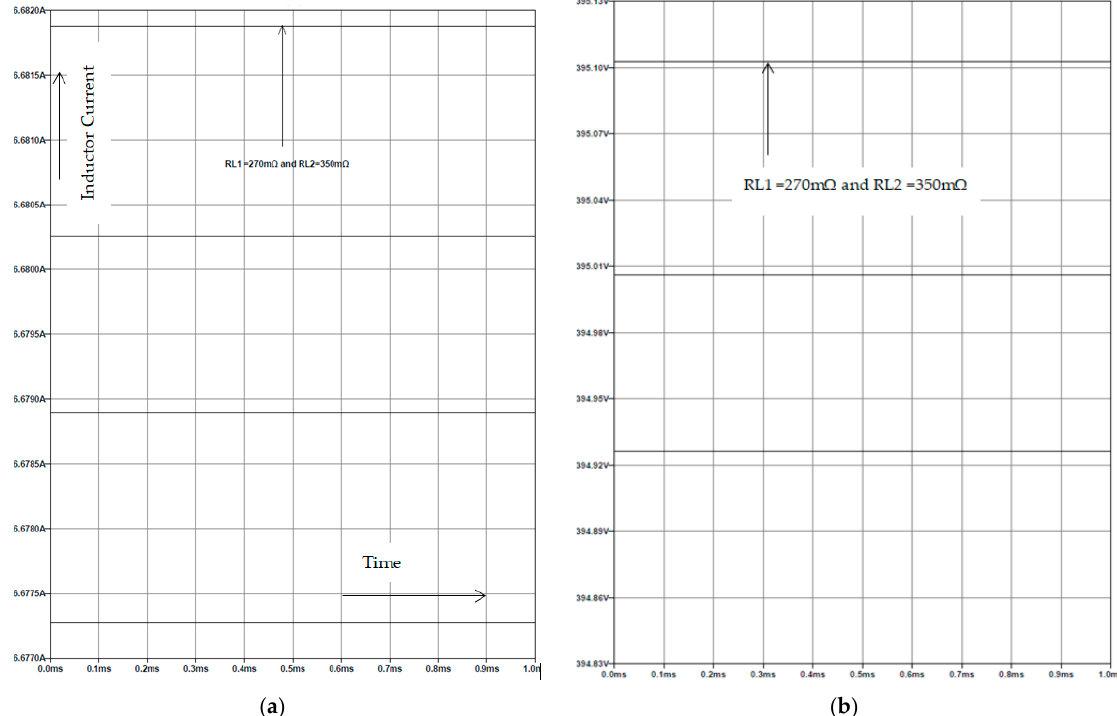
Figure 13. Variation of iL1 and V 0 with change in R L (SEPIC). ( a ) Output Voltage Vs. Control Voltage, ( b ) Inductor 1 Current Vs. Control Voltage